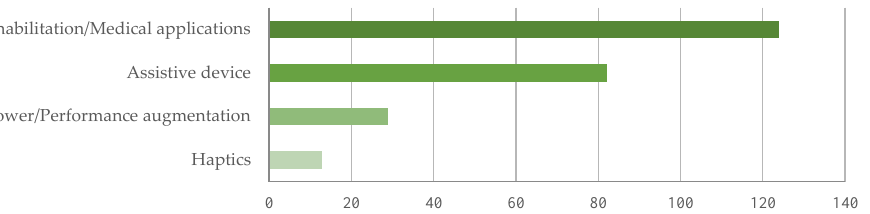
Figure 6. The distribution of exoskeletons by purpose. Studies on exoskeletons for rehabilitation (or more generally for medical applications) and assistive devices cover the 58% and the 38%, respectively.